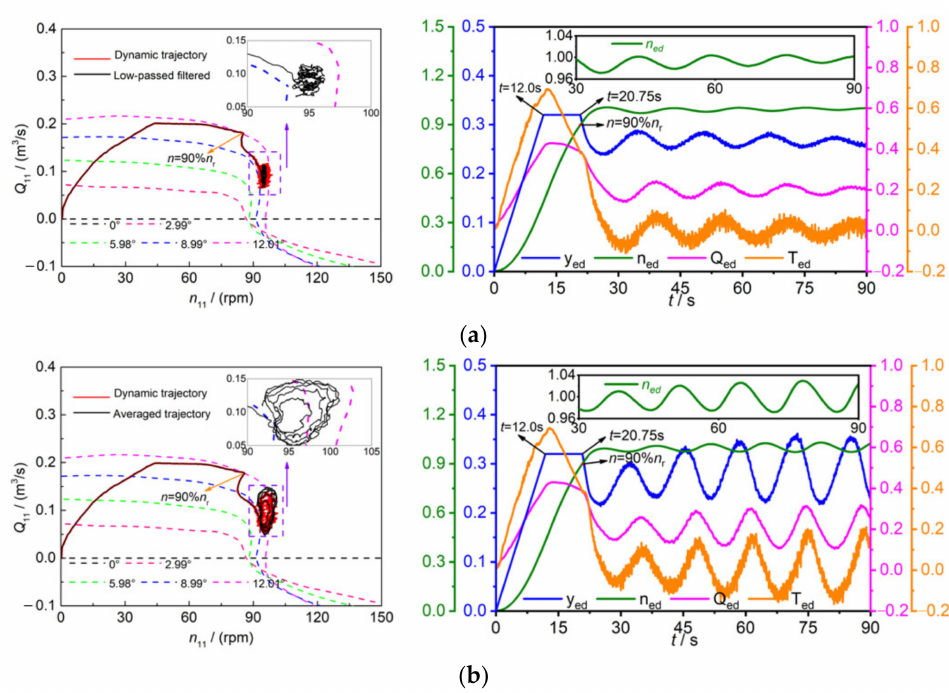
Figure 5. Dynamic trajectories of working point and histories of macro parameters. ( a ) Case1; ( b ) Case2; where, y ed , n ed , Q ed , and T ed are the dynamic values normalized by the rated